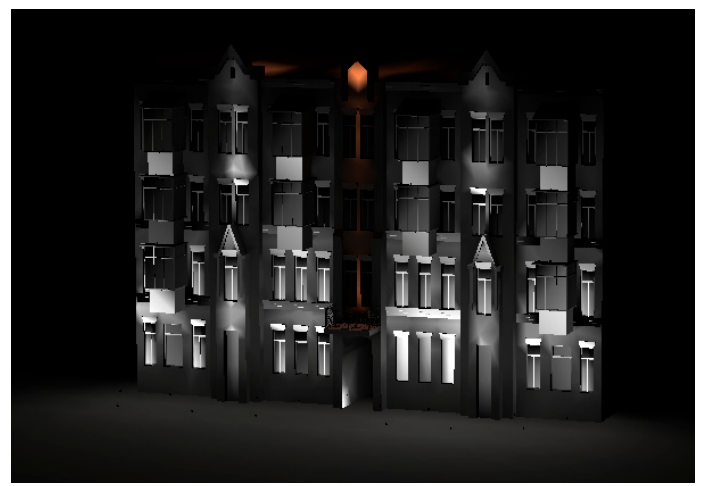
Figure 27. Fast communication of impressionism based on Monet’s painting “Impression”—Scene 2.